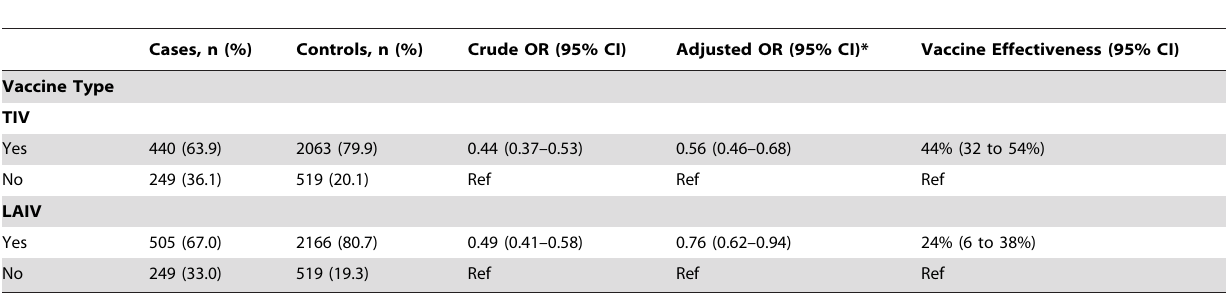
Table 5. Vaccine-specific Crude and Adjusted OR for Cases Received the 2008–2009 Trivalent Influenza Vaccine (TIV) or Live Attenuated Influenza Vaccine (LAIV).